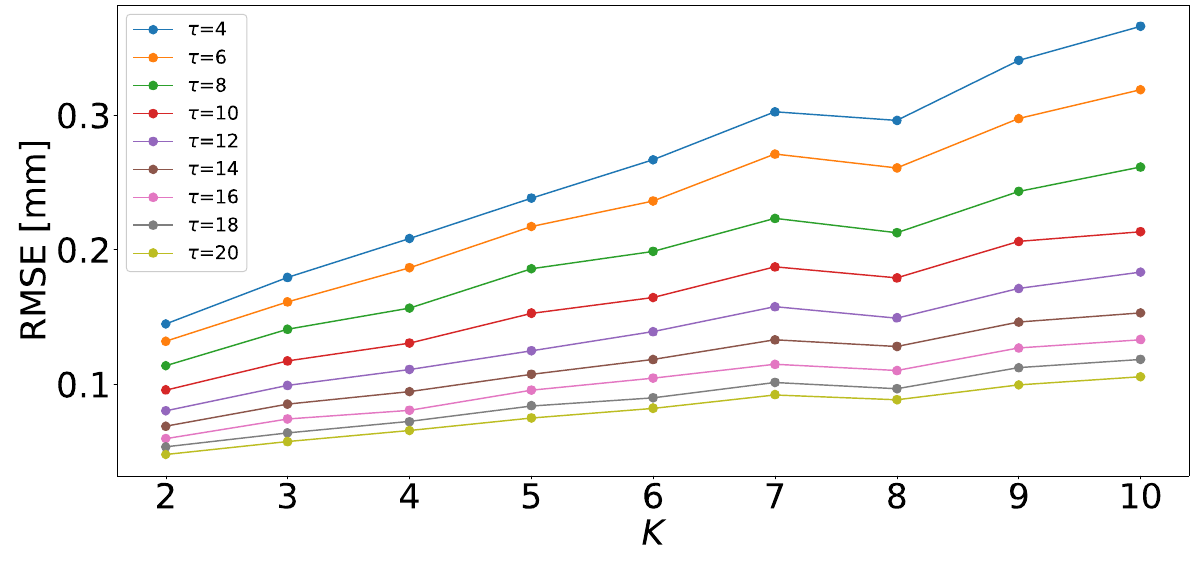
Figure 9. RMSE variation with respect to K for different τ values.